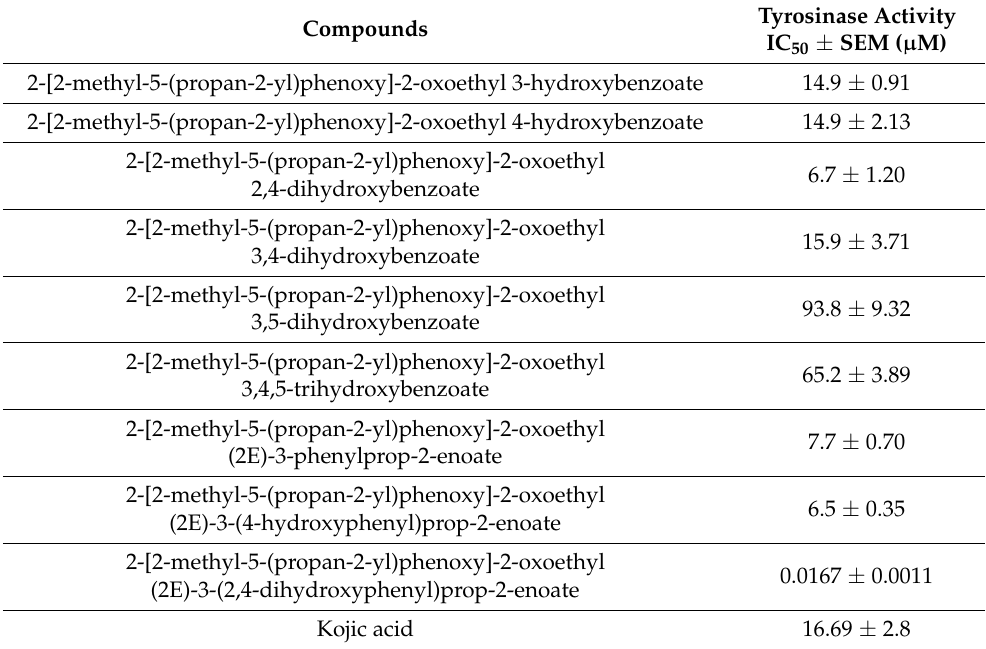
Table 2. Carvacrol derivatives with inhibitory potential against